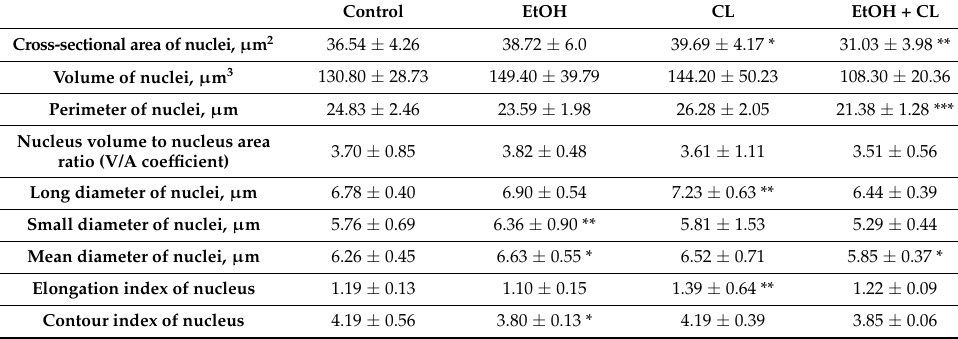
Table 1. Results of micromorphometric studies of hepatocytes of rats. Control EtOH CL EtOH + CL Control Cross-sectionalareaofnuclei, µ m